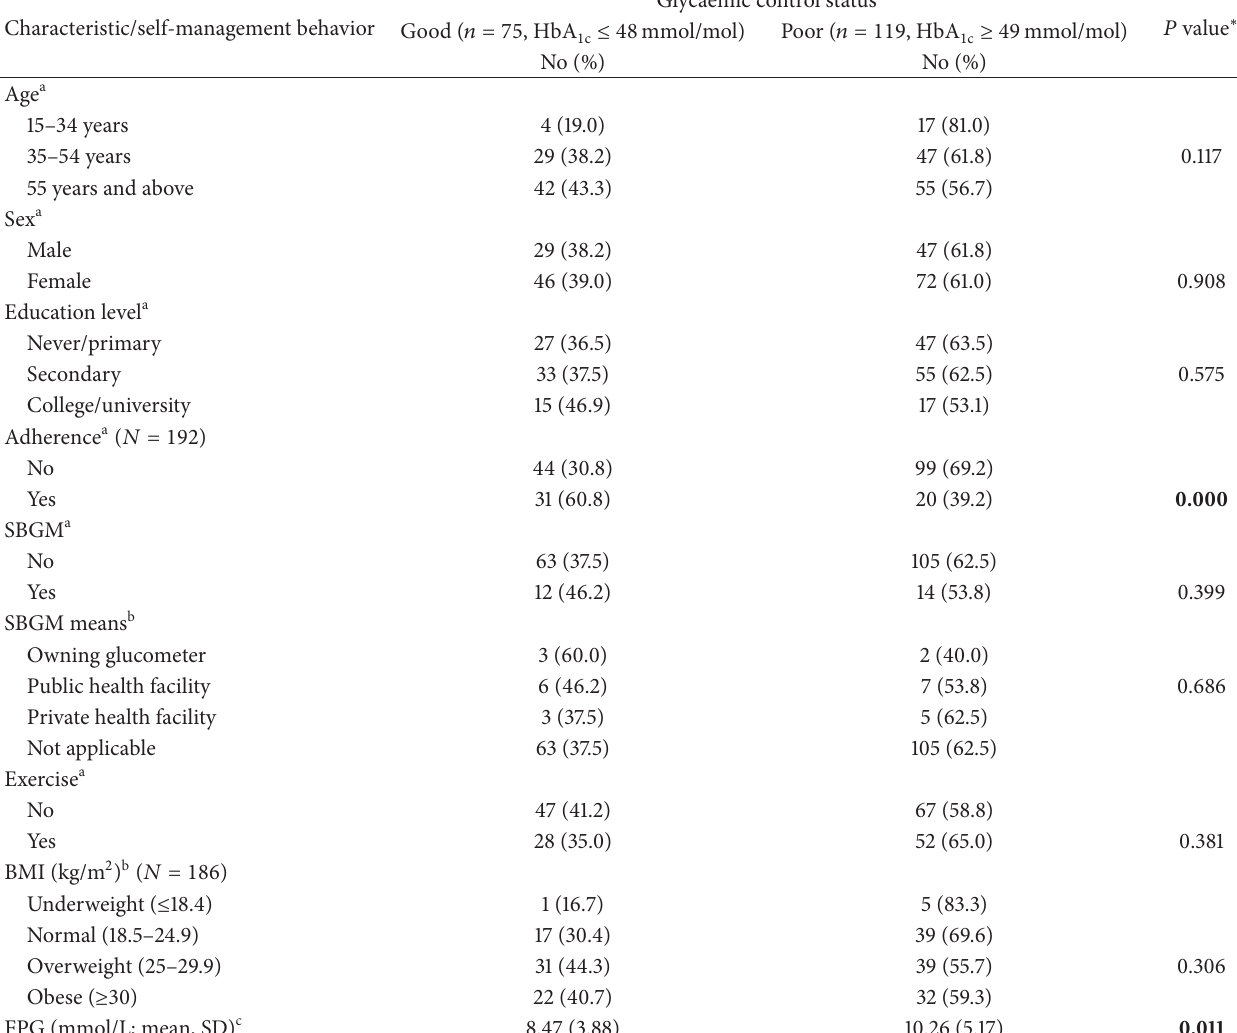
Table 2: Glycaemic control status by characteristics/self-management behaviours of the participants at the University Teaching Hospital. Characteristic/self-management behavior